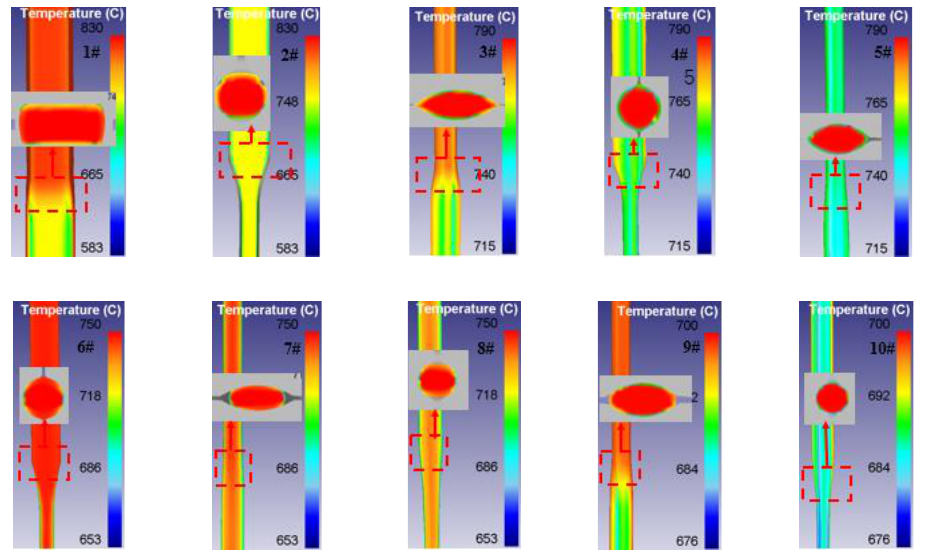
Figure 8. Equivalent temperature field of copper rod rolling and rolling sections in hot continuous rolling.